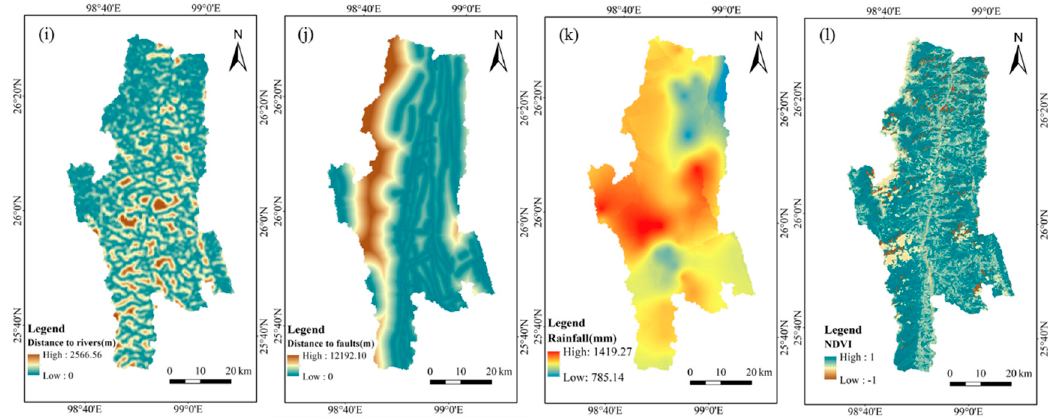
Figure 3. Landslide conditioning factors ( a ) Elevation, ( b ) Slope angle, ( c ) Slope aspect, ( d ) Plan curvature, ( e ) Profile curvature, ( f ) ERG, ( g ) Land use, ( h ) Distance to roads, ( i ) Distance to rivers, ( j ) Distance to faults, ( k ) Annual rainfall, ( l ) Normalized difference vegetation index (NDVI).